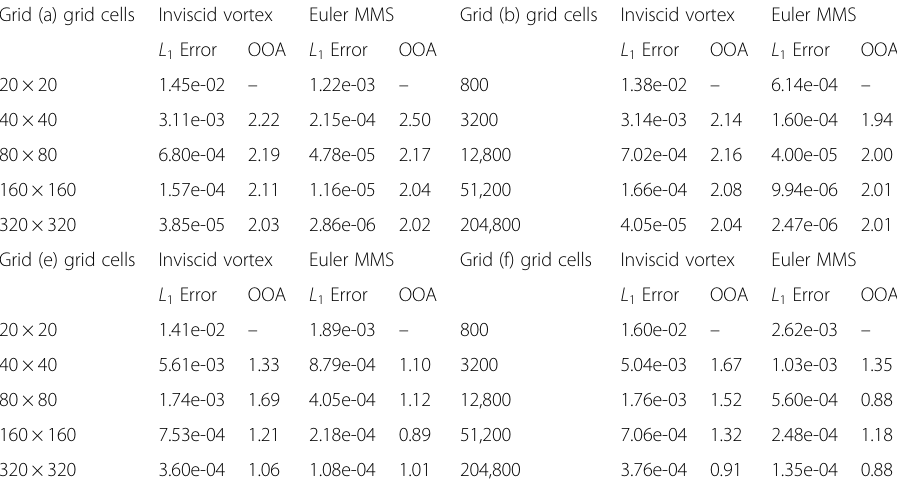
Table 6 Validation of the MMS procedure Grid (a) grid cells Inviscid